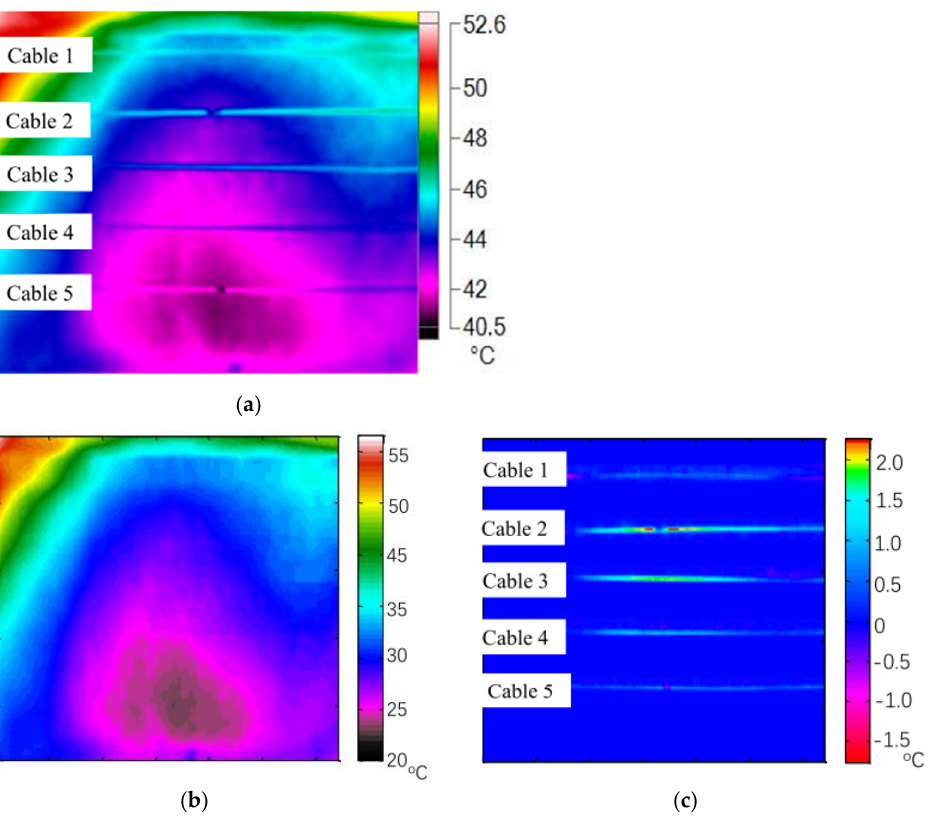
Figure 9. Removal of the background temperature of the infrared image (the picture shows the Group #1 cables heated for 80 s). ( a ) Original image. ( b ) Image of background. ( c ) Difference image obtained after subtraction.